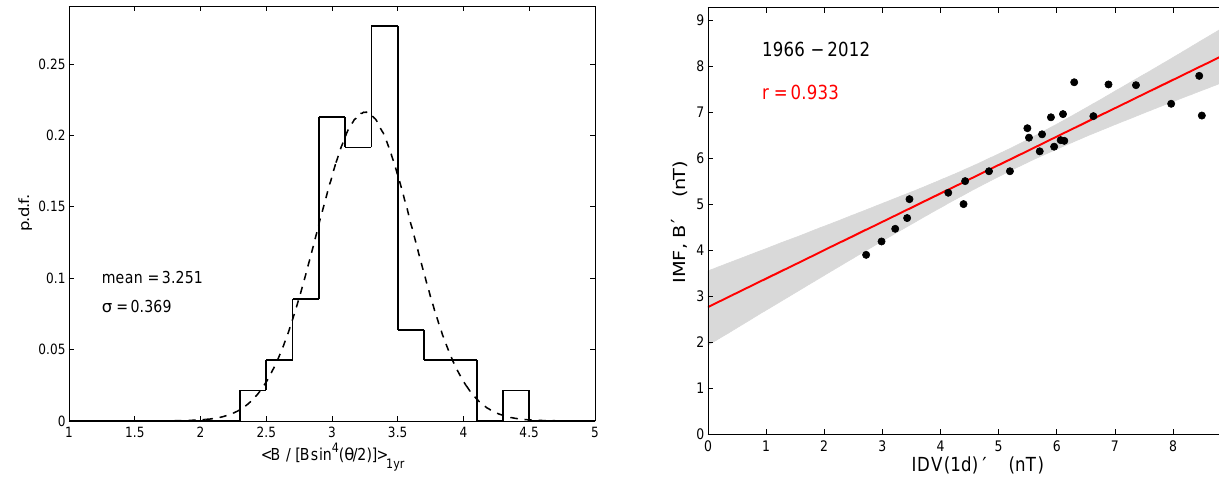
Fig. 5. Scatter plot of annual means of the near-Earth IMF, B 0 , as a function of the simultaneous mean of the new composite geomag- netic index IDV(1d) 0 . The plot covers 1966–2012 (inclusive). The effect of the drift in the magnetic latitudes due to the secular change in the geomagnetic field has also been accounted for. The primes denote that before taking annual means, both IDV(1d) and B data have been removed if there is less than 75% coverage of IMF moni- toring during the relevant 2d IDV(1d) interval and annual means are only considered if there is at least 50% data coverage in a year. The red line is the best linear fit and grey area defines the 2 σ uncertainty band on this fit, derived using a Monte Carlo technique, allowing for the uncertainties introduced by the IMF orientation factor sin 4 (θ/ 2) and the experimental uncertainties in both the IMF and IDV(1d) index. The linear correlation coefficient of fitted and observed pa- rameters is r = 0 . 933 and 10 of the 32 values (31%) lie outside the predicted uncertainty